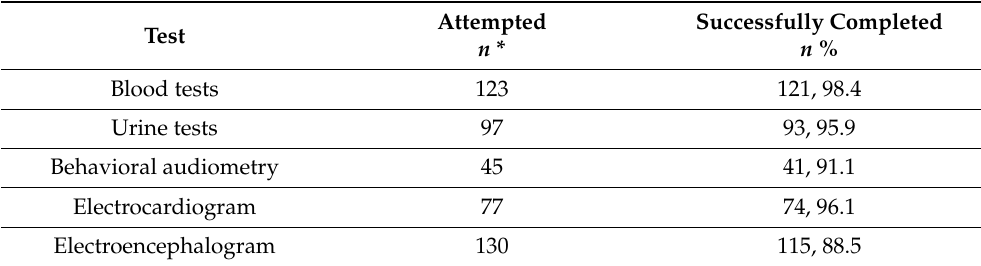
Table 2. Completion rate of laboratory and instrumental tests in children with